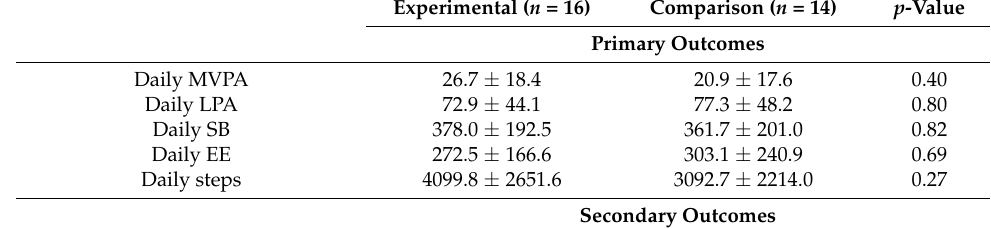
Table 2. Baseline comparisons for participants’ primary and secondary outcomes * ,a